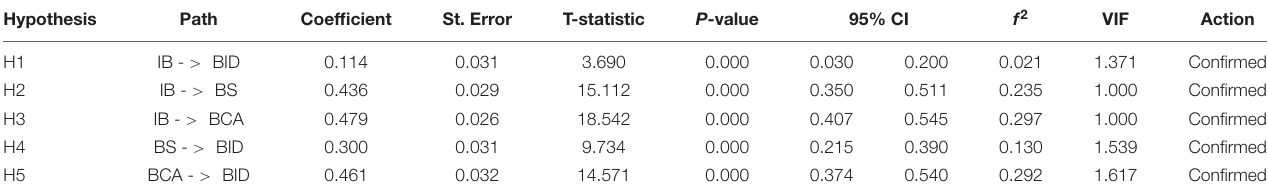
TABLE 5 | Hypotheses testing, standardized coefficients (PLSc-SEM). Hypothesis Path